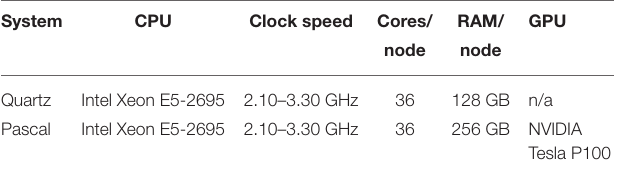
TABLE 2 | Hardware used to run